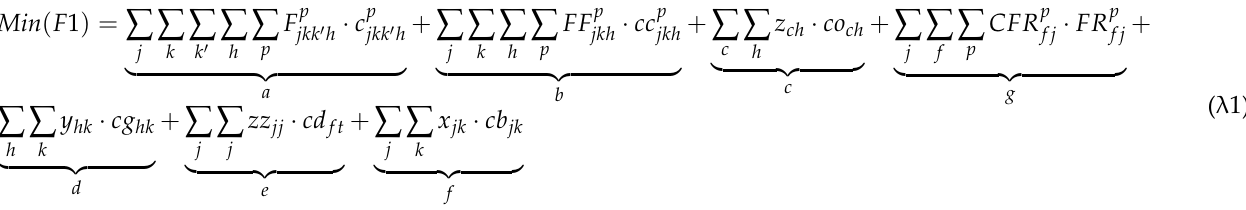
tory’s nodes. Constraint (3) allocates customers to non‑central hub centers. Constraints (5) and (6) allocate non‑hub centers h to central hub k so that each central hub connects to at least one non‑central